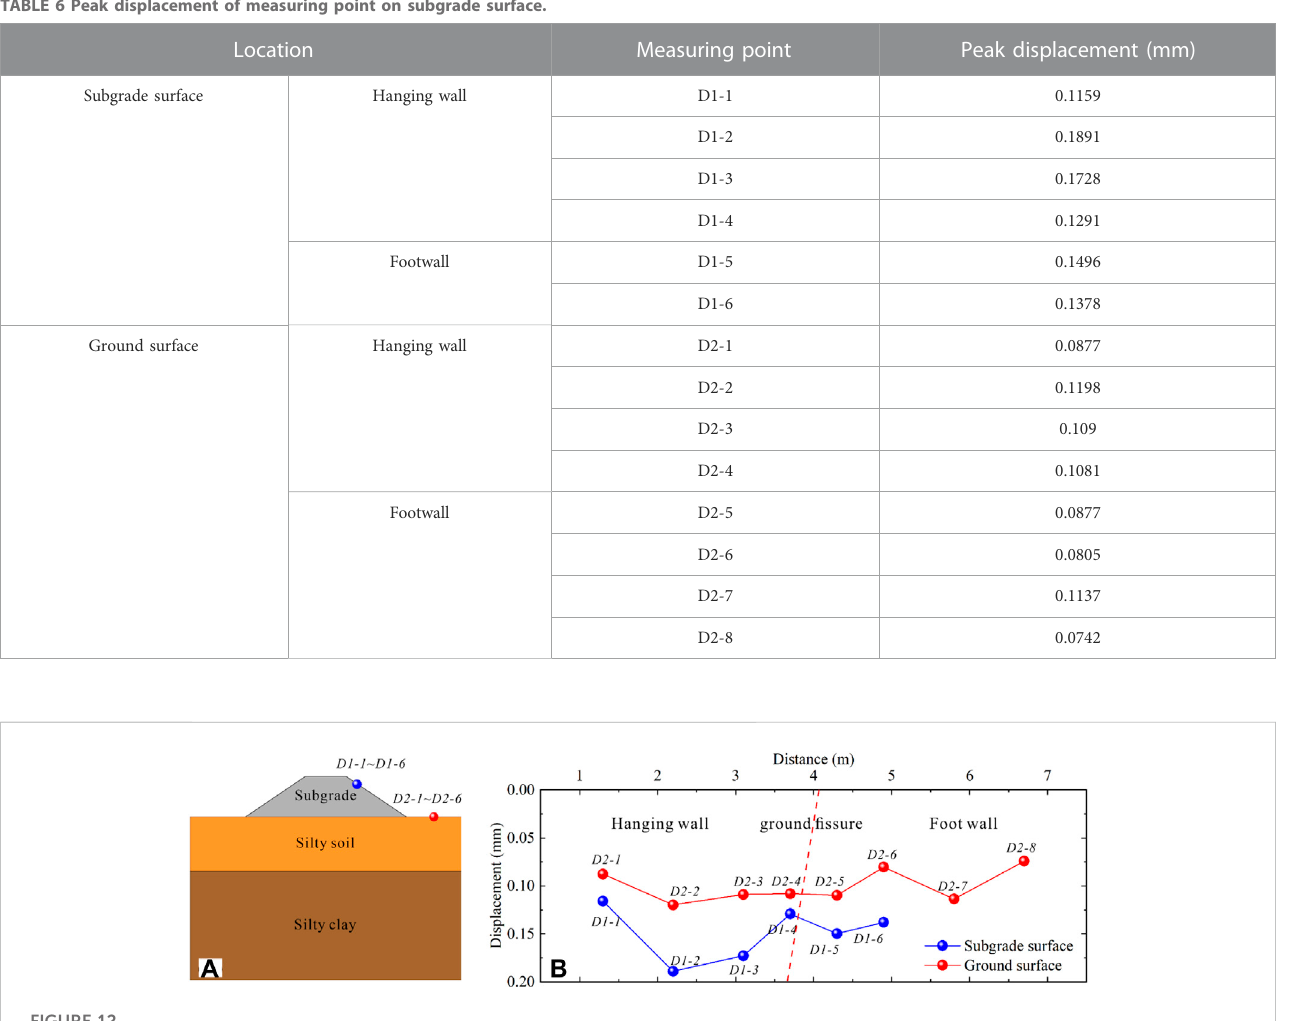
TABLE 6 Peak displacement of measuring point on subgrade surface.